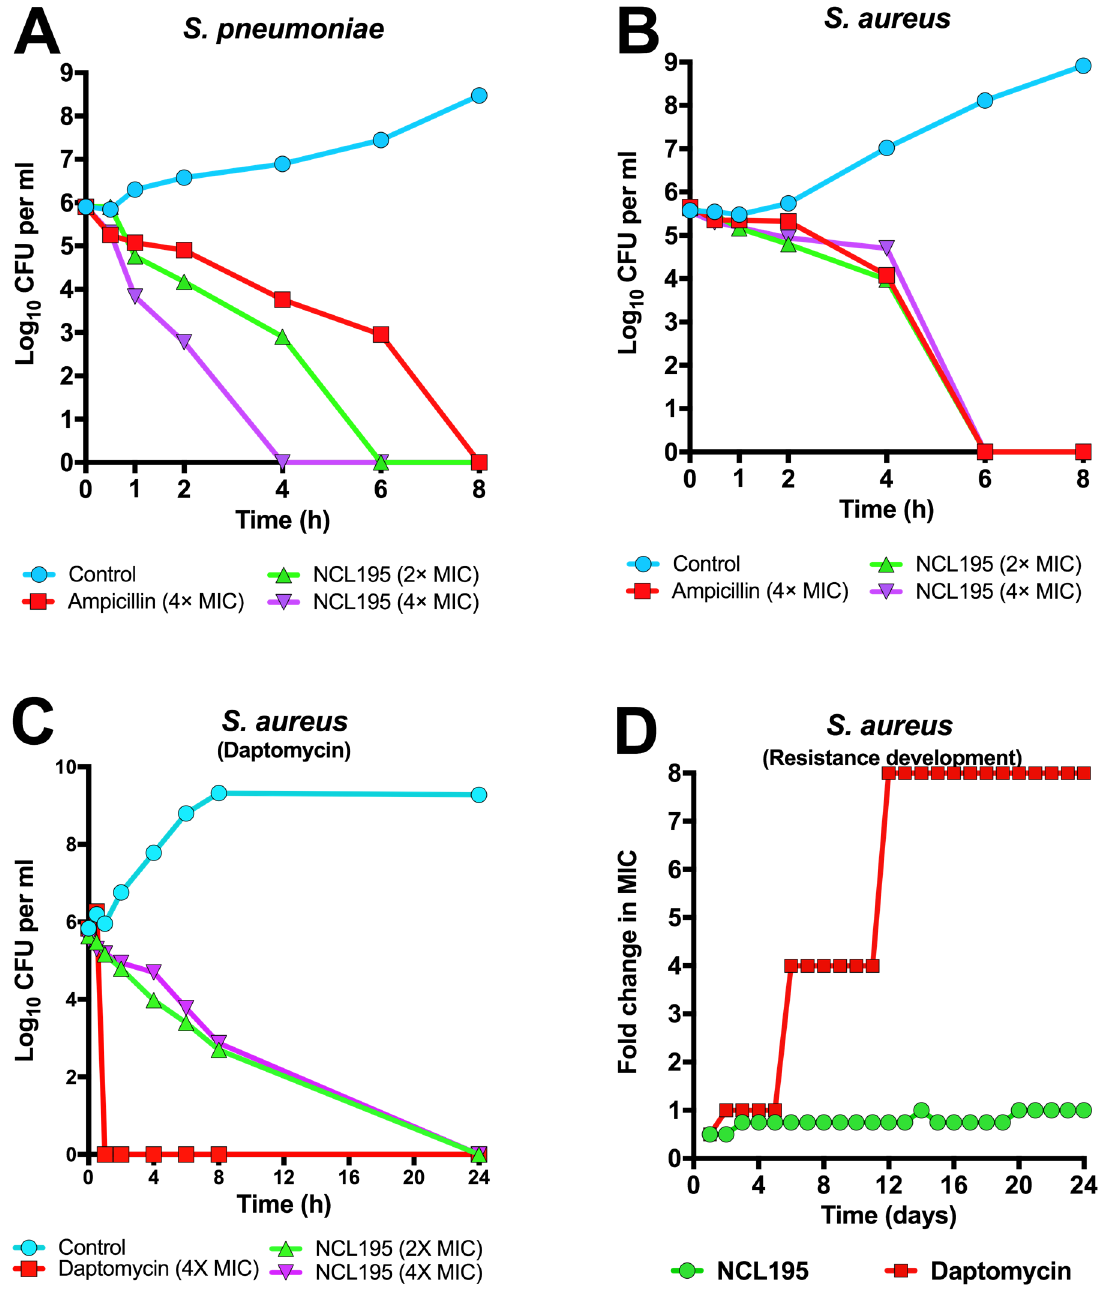
Fig 2. Time kill and point of resistance assays. NCL195 was preparedat 2 × and 4 × MIC (using 4 × MIC of ampicillin(or 4 × MIC of daptomycin) and normalsaline as controls) in either LB broth supplemented with 3% lysed horse blood and 5% horse serum for S . pneumoniae D39 ( A ) or LB broth without supplementation for S . aureus Xen29( B and C ). Cultures were incubatedstaticallyat 37˚C, 5% CO 2 (for S . pneumoniae D39) or at 37˚C with agitation at 200 rpm (for S . aureus Xen29). Sampleswithdrawnat indicatedtimes and plated on HBA overnight at 37˚C, 5% CO 2 (for S . pneumoniae D39) or at 37˚C with aeration(for S . aureus Xen29) for bacterialenumeration. For ( D ), S . aureus Xen29 was grown in 2 ml LB broth the presenceof 0.5 × MIC, 0.75 × MIC, 1 × MIC, 1.5 × MIC, 2 × MIC, and 4 × MIC of NCL195,using 1 × MIC, 4 × MIC and 8 × MIC of daptomycinas